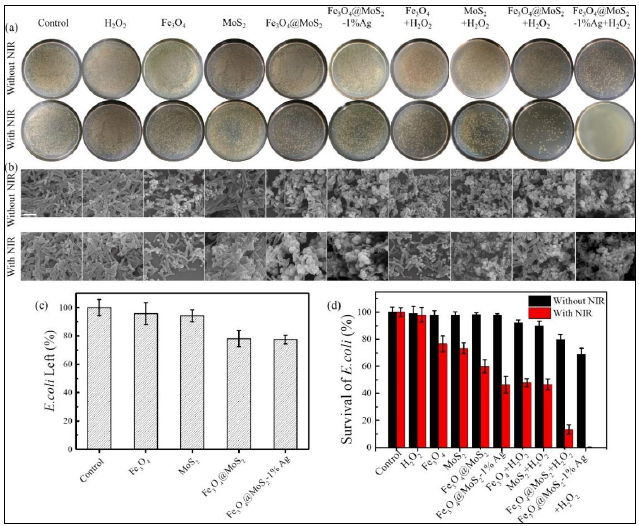
Figure 4. ( a ) Photographs of standard agar plates showing viable bacterial colonies for various controls and samples, without and with NIR light irradiation; ( b ) SEM images of bacteria treated with corresponding samples; ( c ) bacteria percentage left in the suspension after removing the catalysts; ( d ) percentage survival of bacteria treated with different controls and samples. Reprinted with permission from Ref. [51]. Copyright 2021 Elsevier.